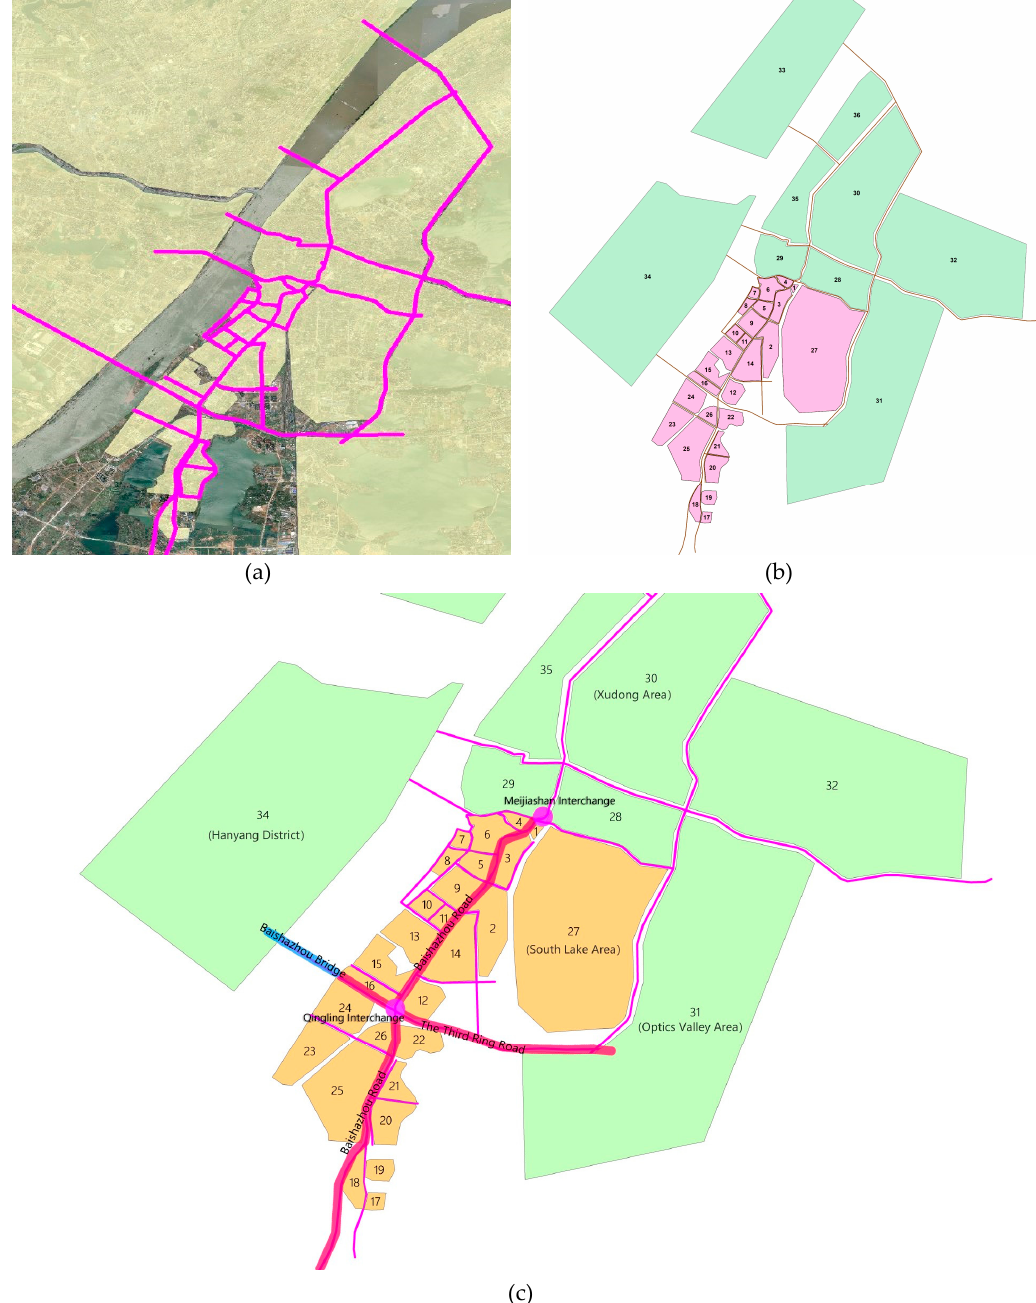
Figure 3. Road network and division of urban spatial units. ( a ) The original blocks and road network; ( b ) Simplified spatial units of land use and road network; ( c ) Names of key Roads and spatial units.